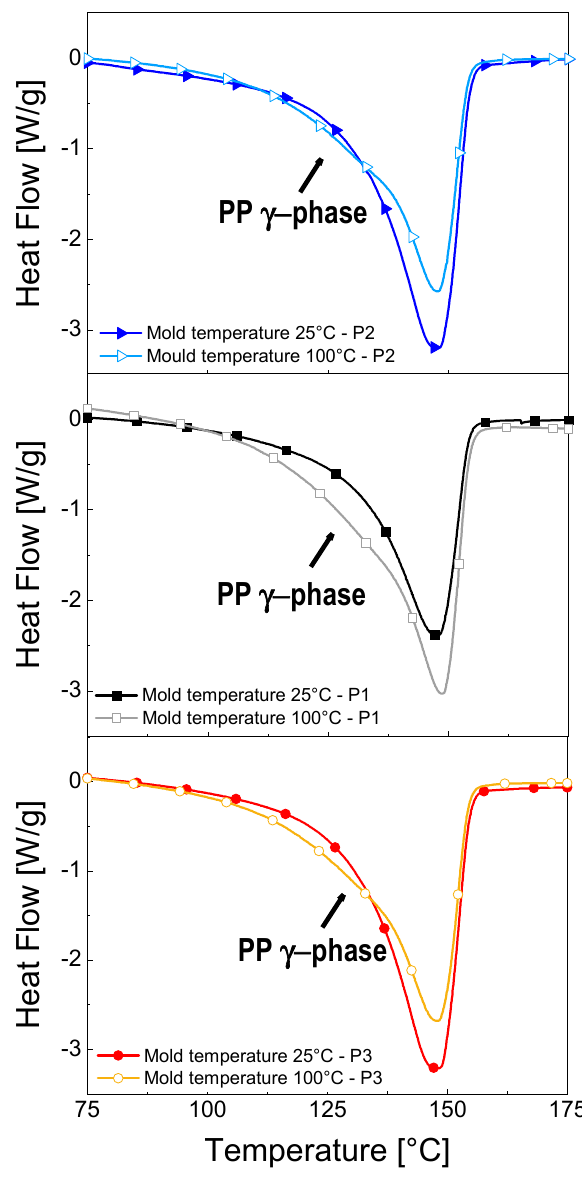
Figure 7. DSC thermograms of 3 wt%-MWCNT nanocomposites manufactured at 25 °C and 100 °C, in the different positions (exo up). Table 2. Degree of crystallinity of 3 wt%-MWCNT nanocomposites as a function of mold tempera- ture in the different positions over the sample.